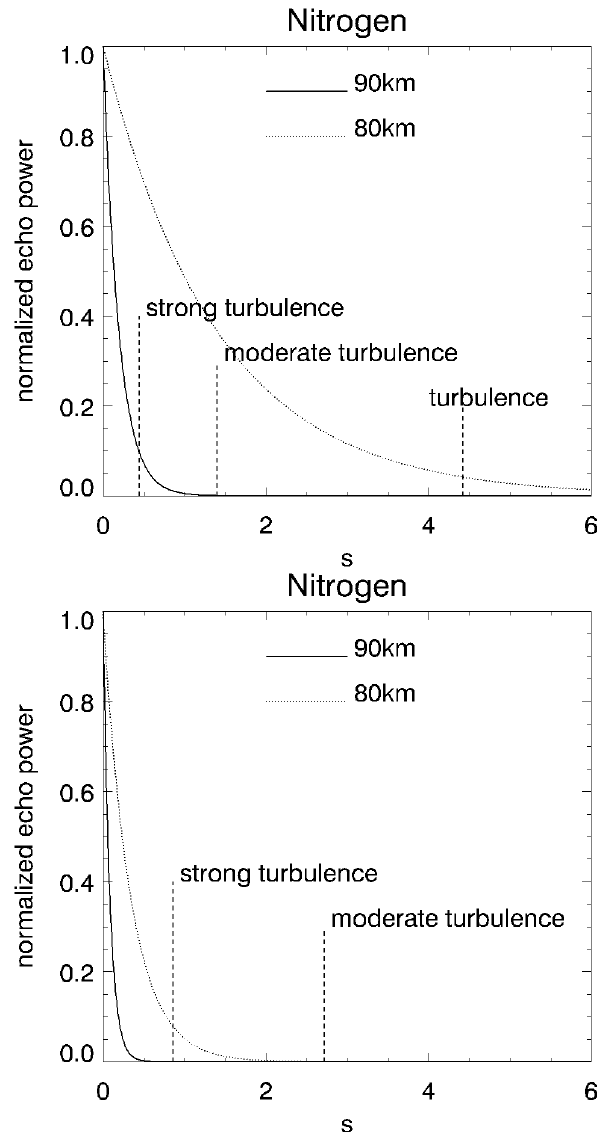
Fig. 4. Simulated meteor trail echoes assuming metal ions. Upper panel: summer; Lower panel: winter. Two heights are shown, 80 and 90km (dotted and solid lines, respectively). The time scales corresponding to “average”, “moderate” and “strong” turbulence are shown by the vertical dashed line segments.